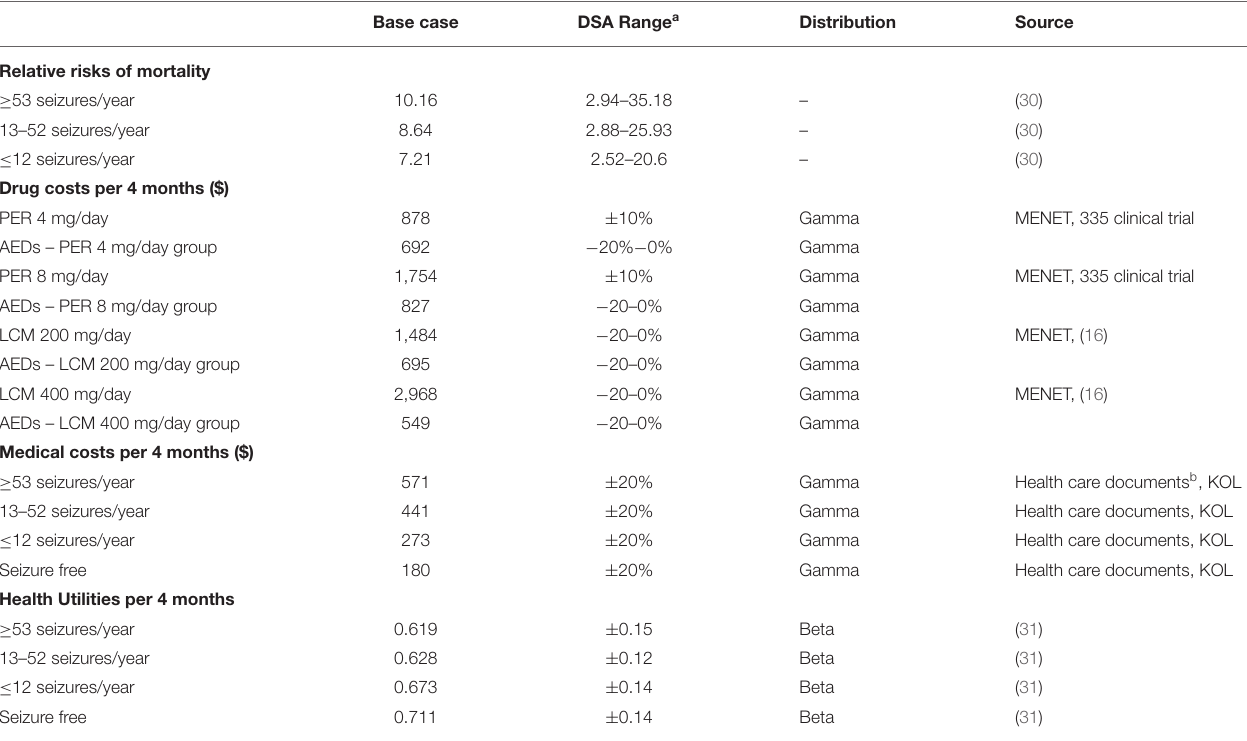
TABLE 3 | Inputs in the CE